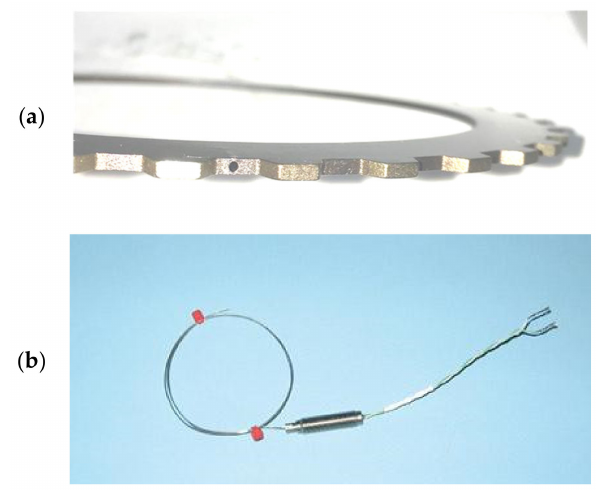
Figure 4. Thermometer hole of the samples ( a ), and the thermocouples ( b ).